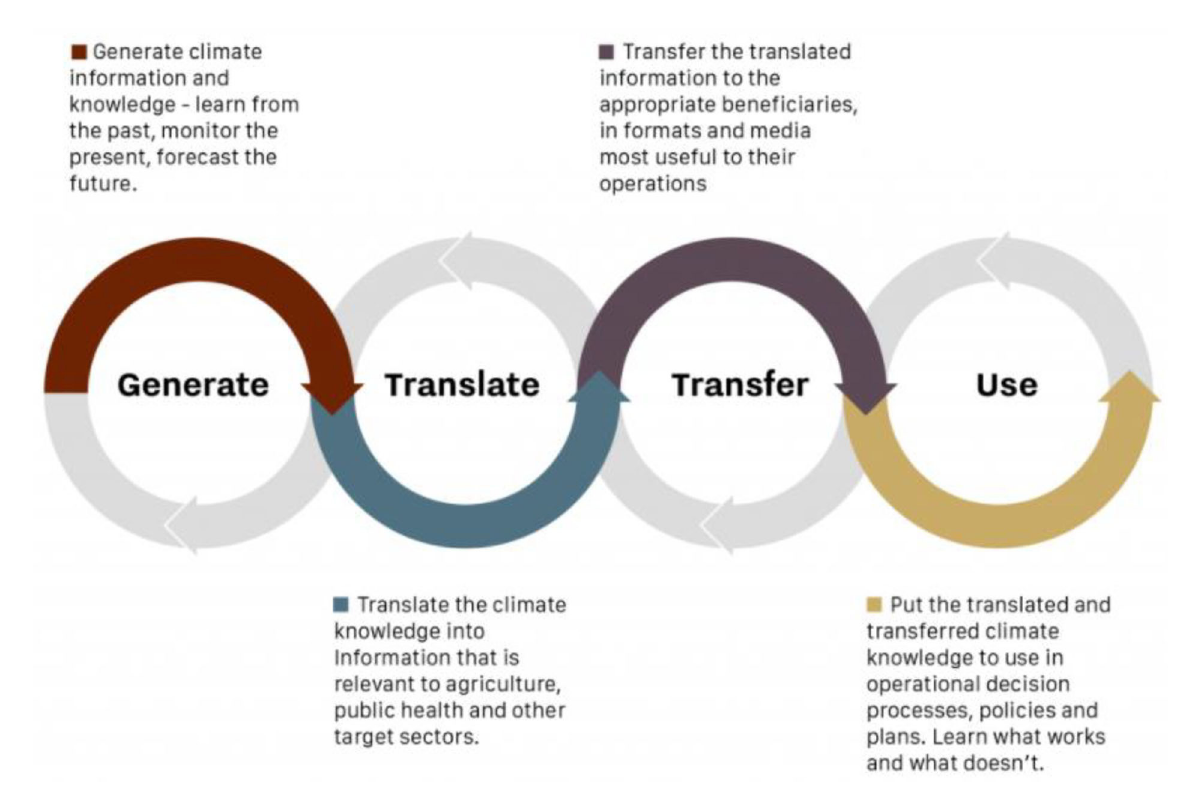
FIGURE2 The four pillars of climate services. The four pillars of climate services include the generation, translation, transfer, and use of climate information. Source: Fiondella (2021).